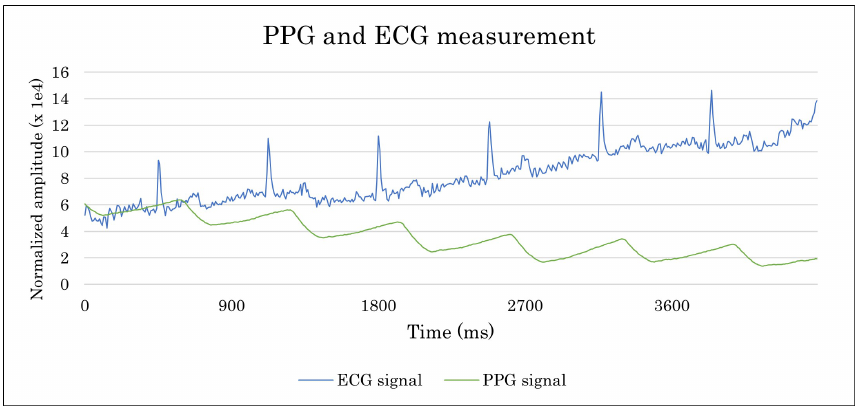
Figure 17. Measurements made with PPG and ECG